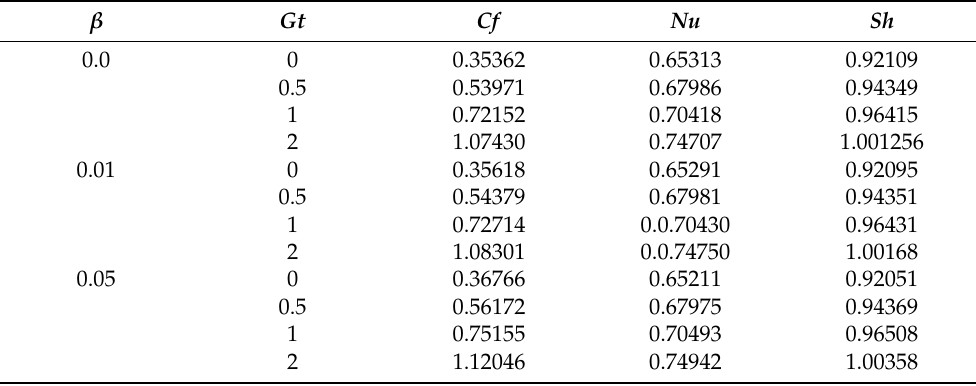
Table 1. Numeric values of local skin friction, local Nusselt, and local Sherwood numbers for distinct values of viscoelastic parameter ( β ) and thermal Grashof number when M = 1.0, R = 0.5, Pr = 0.71,